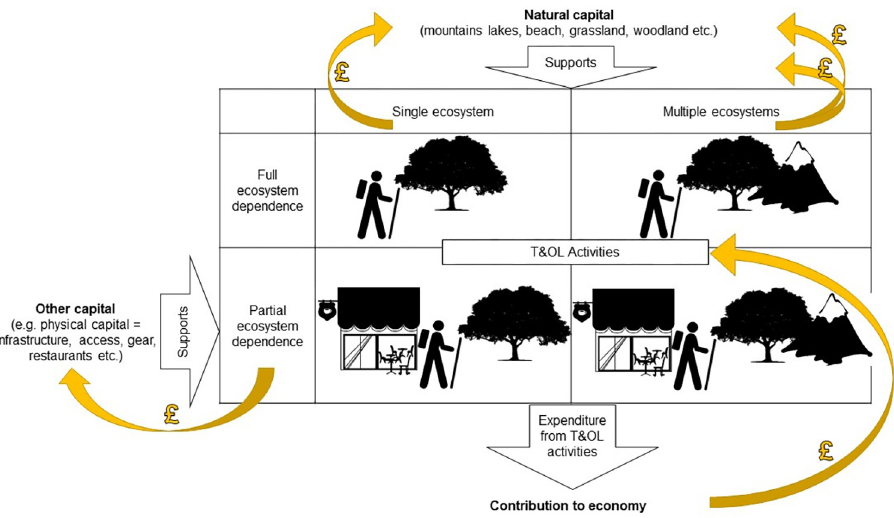
Fig 1. Contribution of other capital (such as physical) and natural capital to T&OL activities and consequently economy. Ecosystems and other capital support T&OL activities. T&OL activity expenditure is therefore is attributable to natural